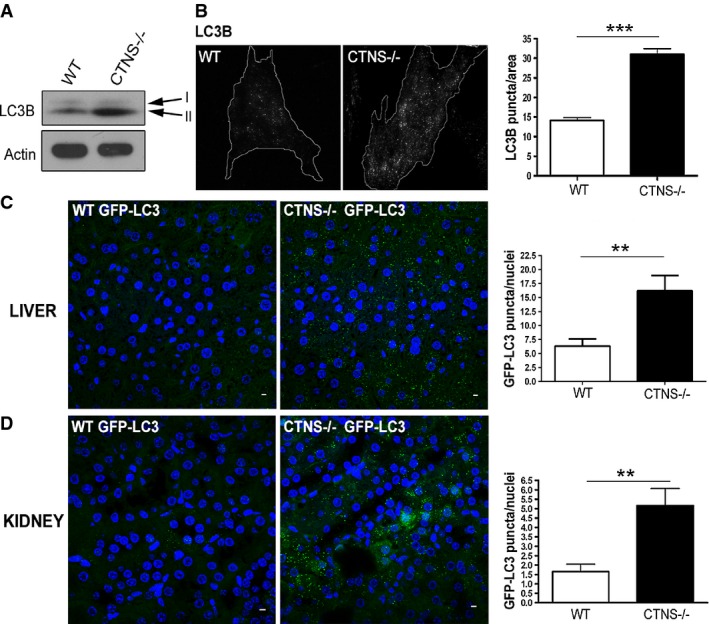
CTNS-deficient cells and tissues have increased number of autophagosomes
Expression levels of the autophagosome marker LC3B-II were evaluated in wild-type (WT) and Ctns−/− fibroblasts by Western blot (WB). Data are representative of five different experiments with similar results.

WT and Ctns−/− fibroblasts were stained using LC3B antibodies and analyzed by fluorescence microscopy. The number of LC3B-positive puncta was quantified by the ImagePro software and normalized per area arbitrary units. Results are mean ± SEM (n = 27 WT and 24 Ctns−/− cells). ***P < 0.001 (unpaired t-test).

Immunofluorescence analysis of liver (C) and kidney (D) tissues from WT and Ctns−/− GFP-LC3 transgenic mice using anti-GFP antibodies. Quantification of LC3 puncta was obtained by counting the number of GFP-positive structures relative to the number of nuclei in the same field, using the ImagePro software. GFP-LC3 puncta were counted by analyzing 6 to 10 fields per tissue section (200–400 nuclei per field), in a total of 3 WT and 3 Ctns−/− mice expressing GFP-LC3. Results are mean ± SEM. In (C), **P = 0.0029; in (D), **P = 0.0025 (unpaired t-test). Scale bar: 5 μm.